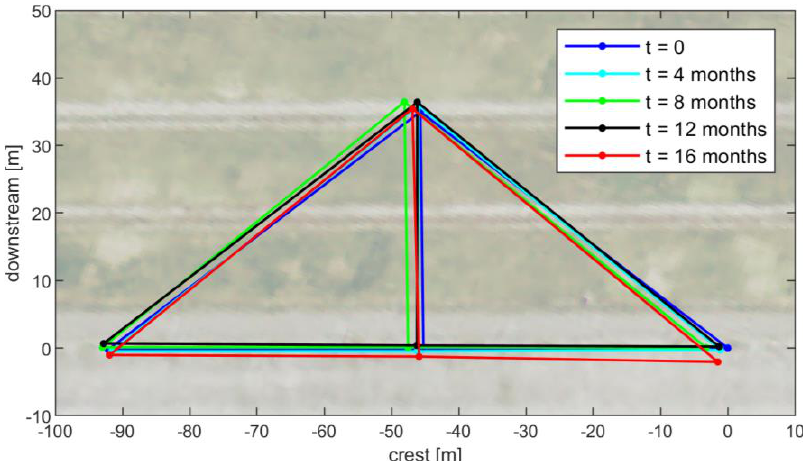
Figure 7. Sketch of the evolution in time of the relative alignment between the four monitored points in the XY plane. Dam orthophoto as background.